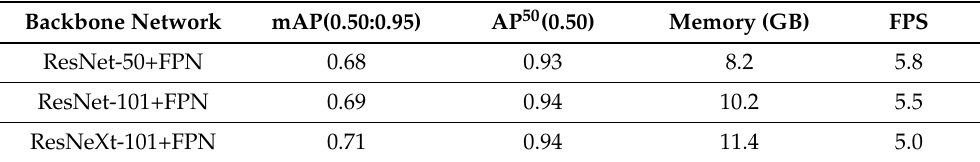
Table 4. Summarizing the trade-off between performance and efficiency of the proposed method with different backbone networks on the ExDark